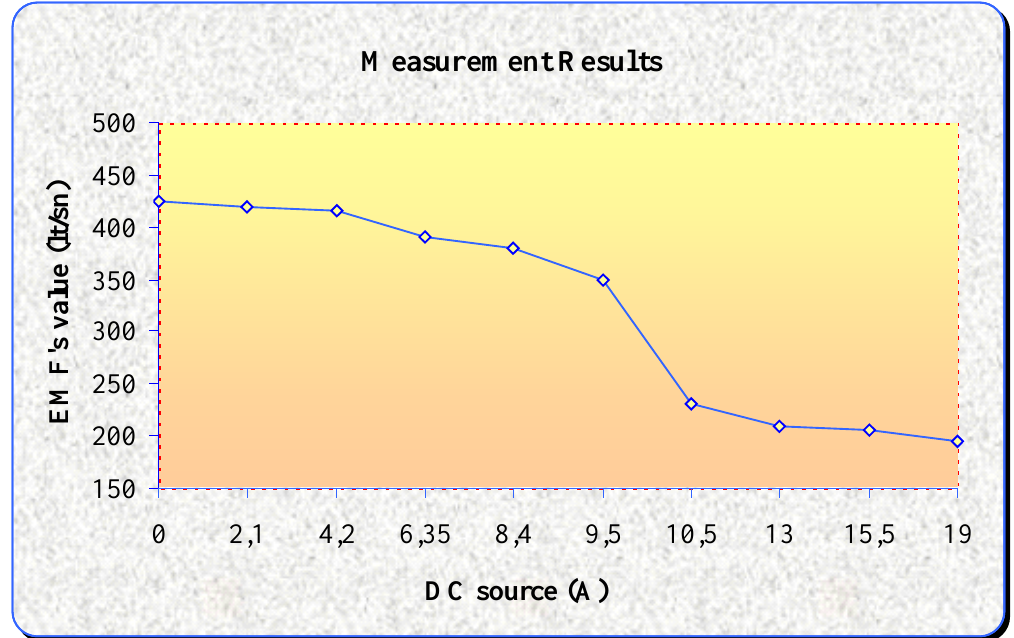
Figure 6. Graphic of EMF value via current.